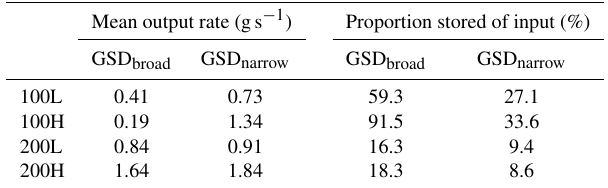
Table 2. Changes in mean slope for the column name experi- ment, given relative to the row name experiment, for GSD broad and GSD narrow respectively. Values are given in %.